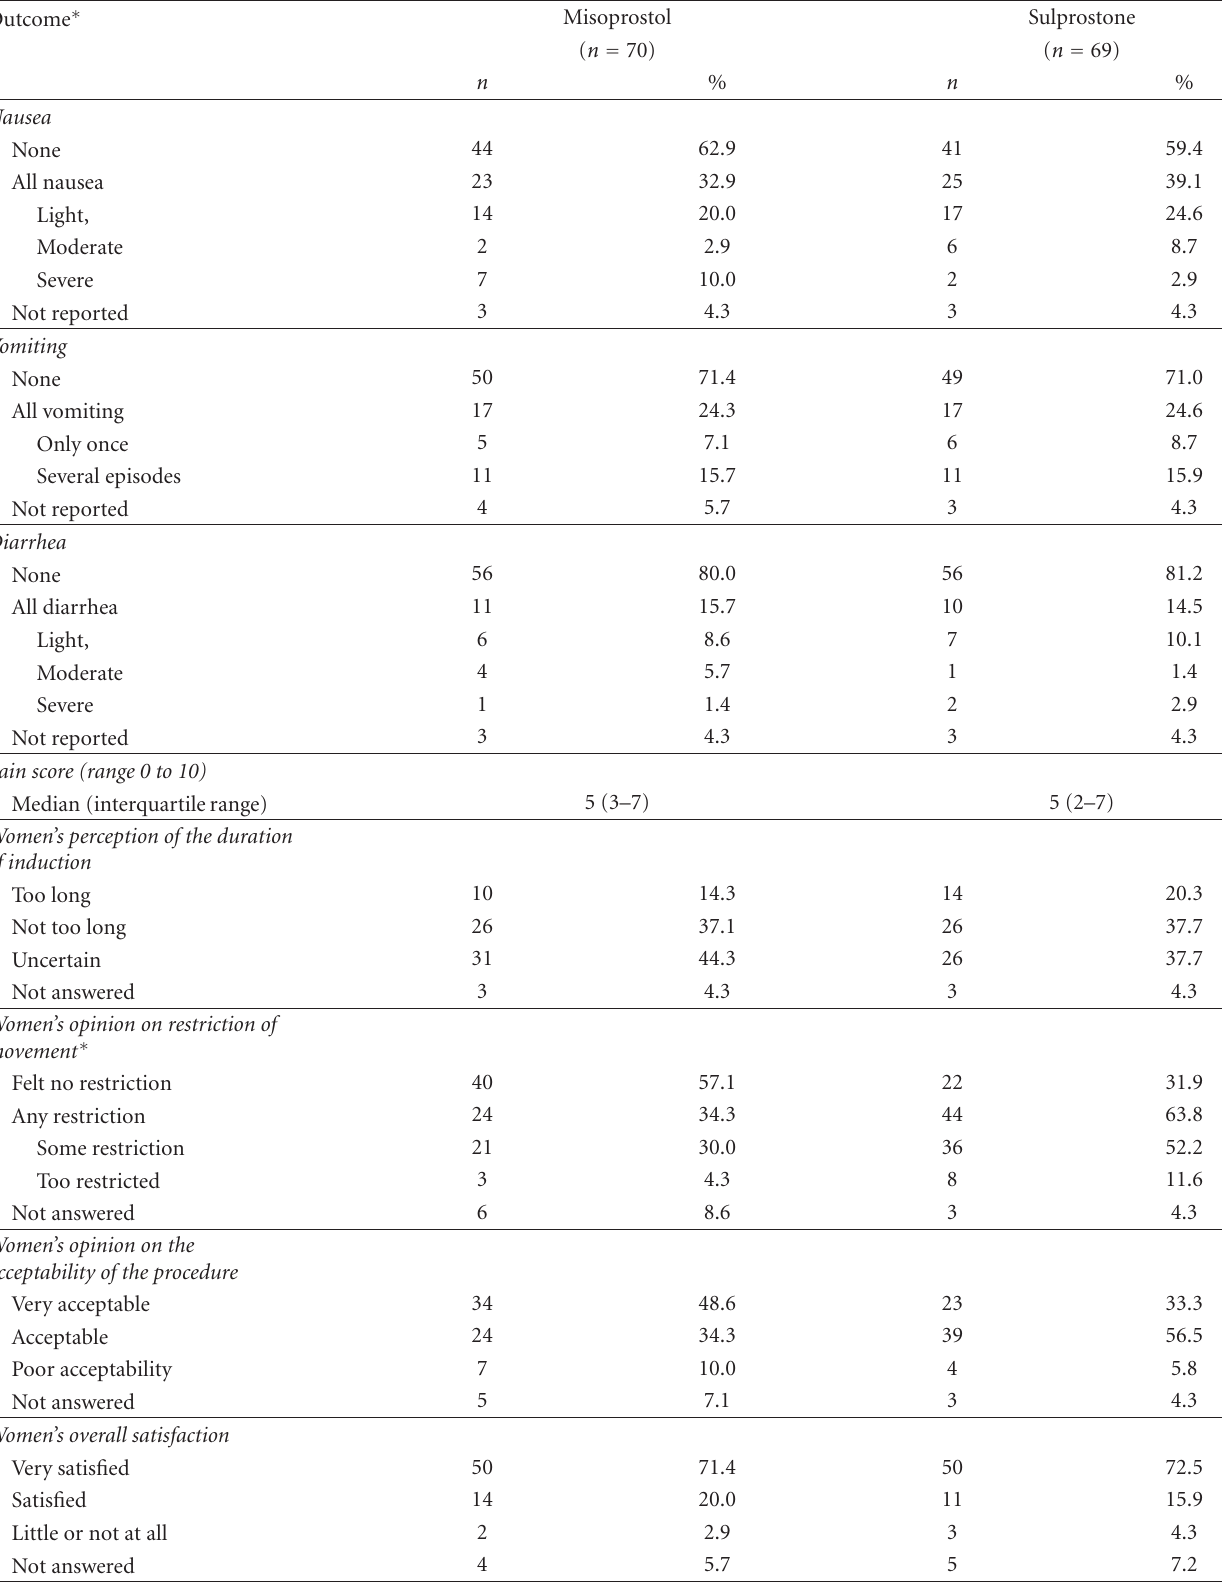
Table 4: Women’s assessment of the treatments and their side e ff